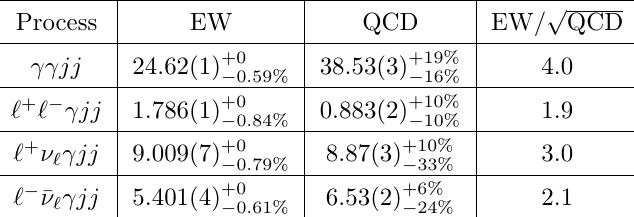
Table 4 . EW and QCD event numbers for di(cid:11)erent processes calculated at NLO with luminosity L = 1 fb (cid:0) 1 . For the charged lepton (cid:12)nal states, both electron and muon are taken into account ( ‘ = e; (cid:22) ) and the cross sections are calculated using VBFNLO version 3.0.0 beta 4. The scale uncertainties in percentage are also